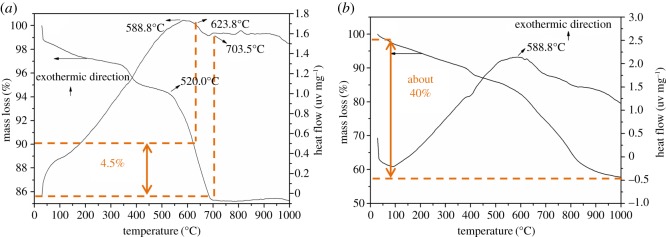
TG-DTA curves of Kuandian ores (a) and Kuandian ores/Na2CO3 (b).